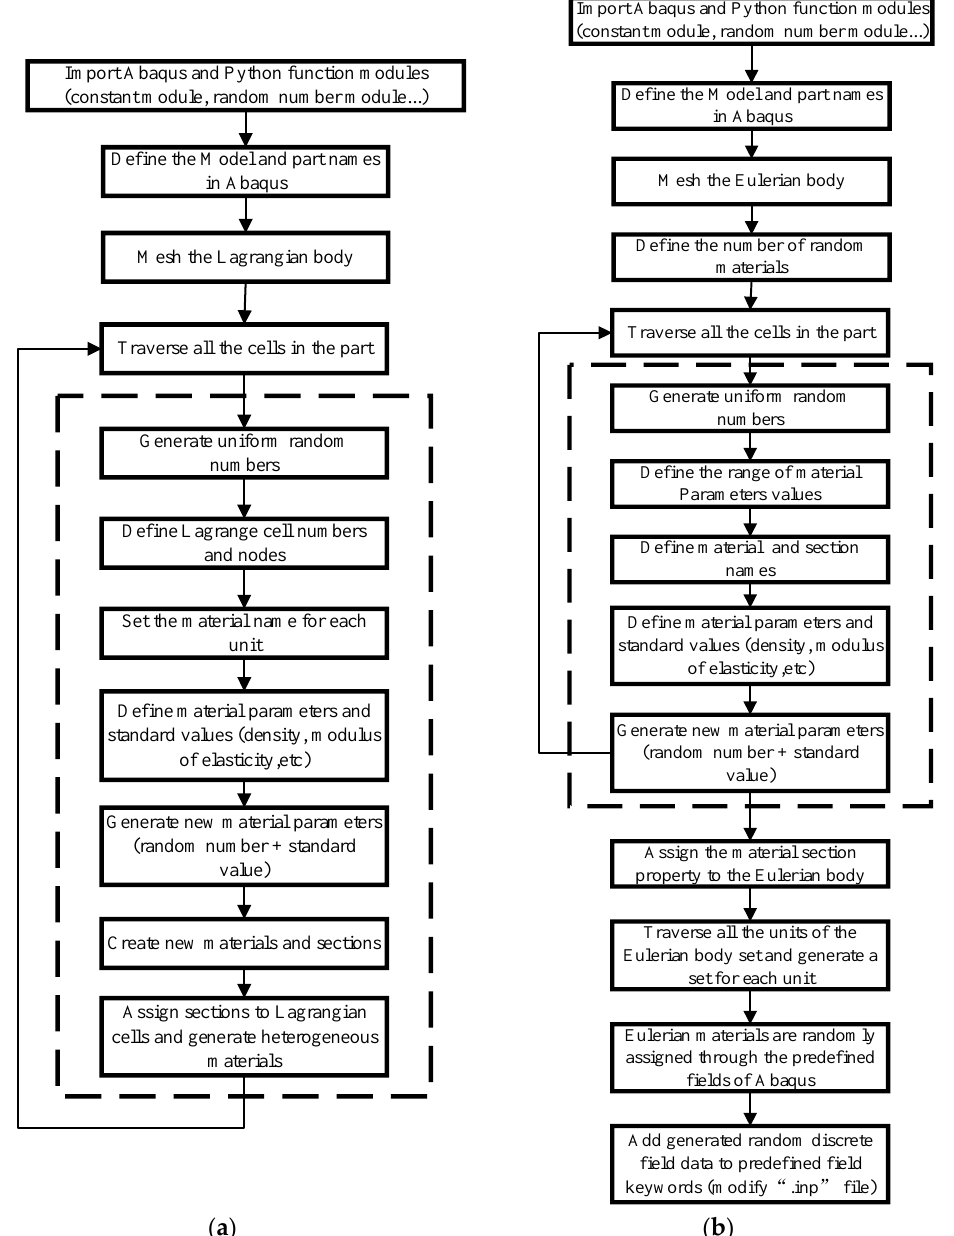
Figure 31. Comparison of the flow chart between ( a ) Lagrangian and ( b ) Eulerian heterogeneous soil establishment.